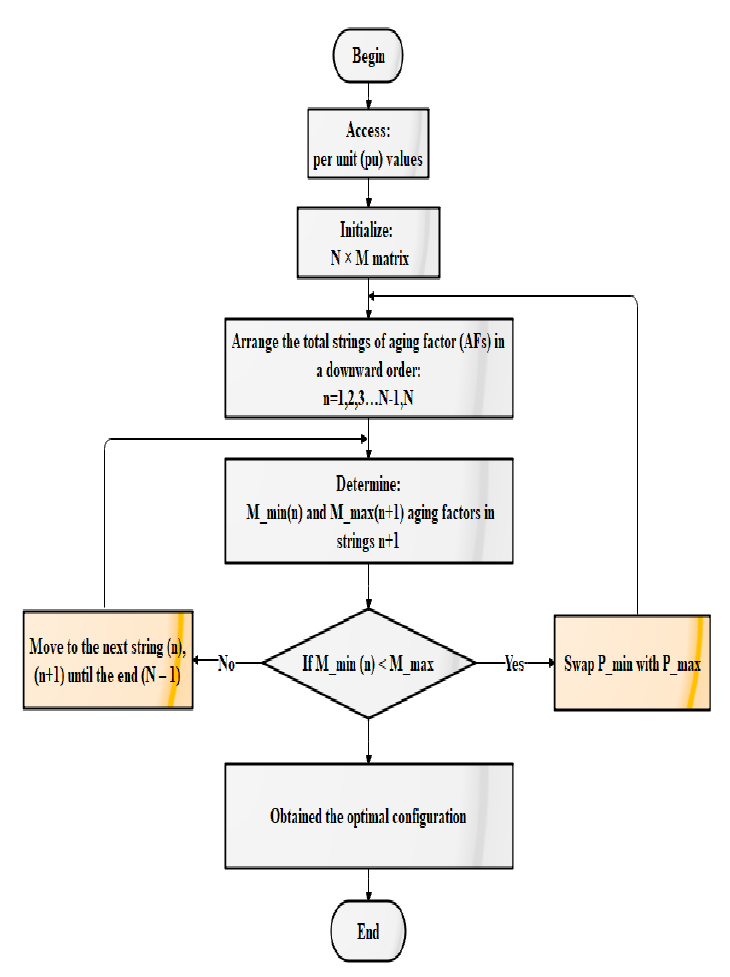
Figure 10. Flowchart of PV reconfiguration algorithm process.